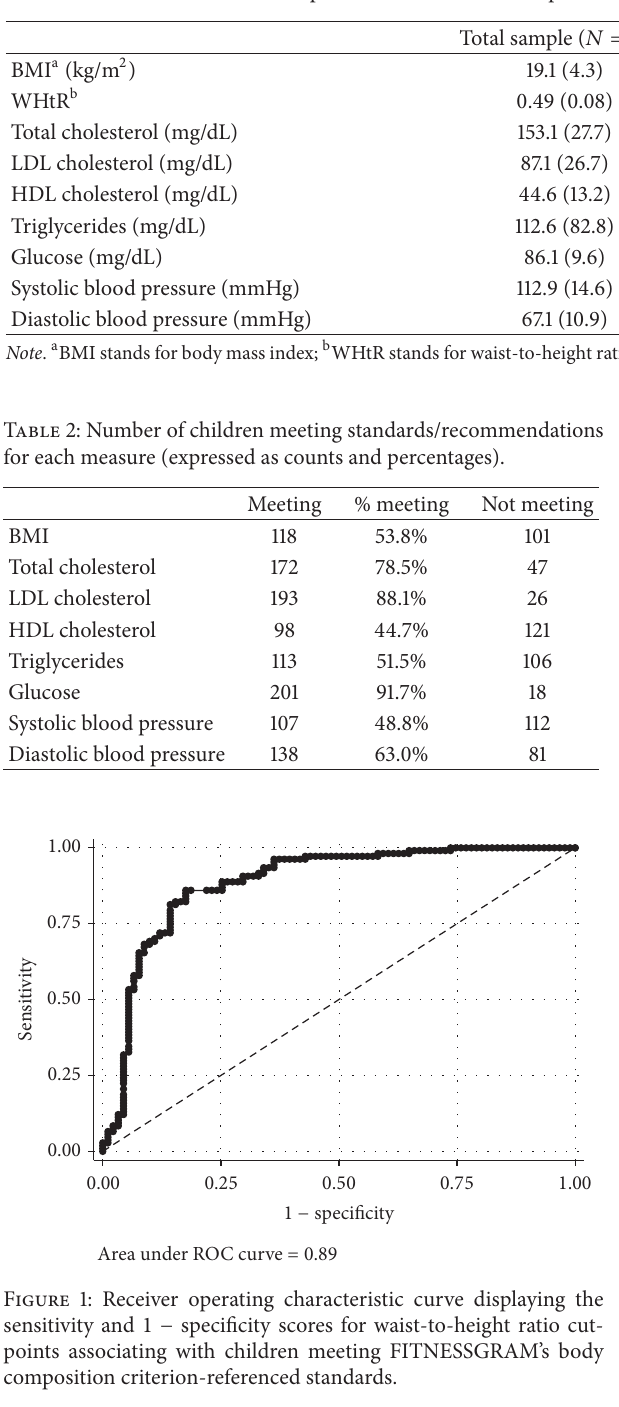
Table 1: Descriptive data for the total sample and within sex groups (means and standard deviations).